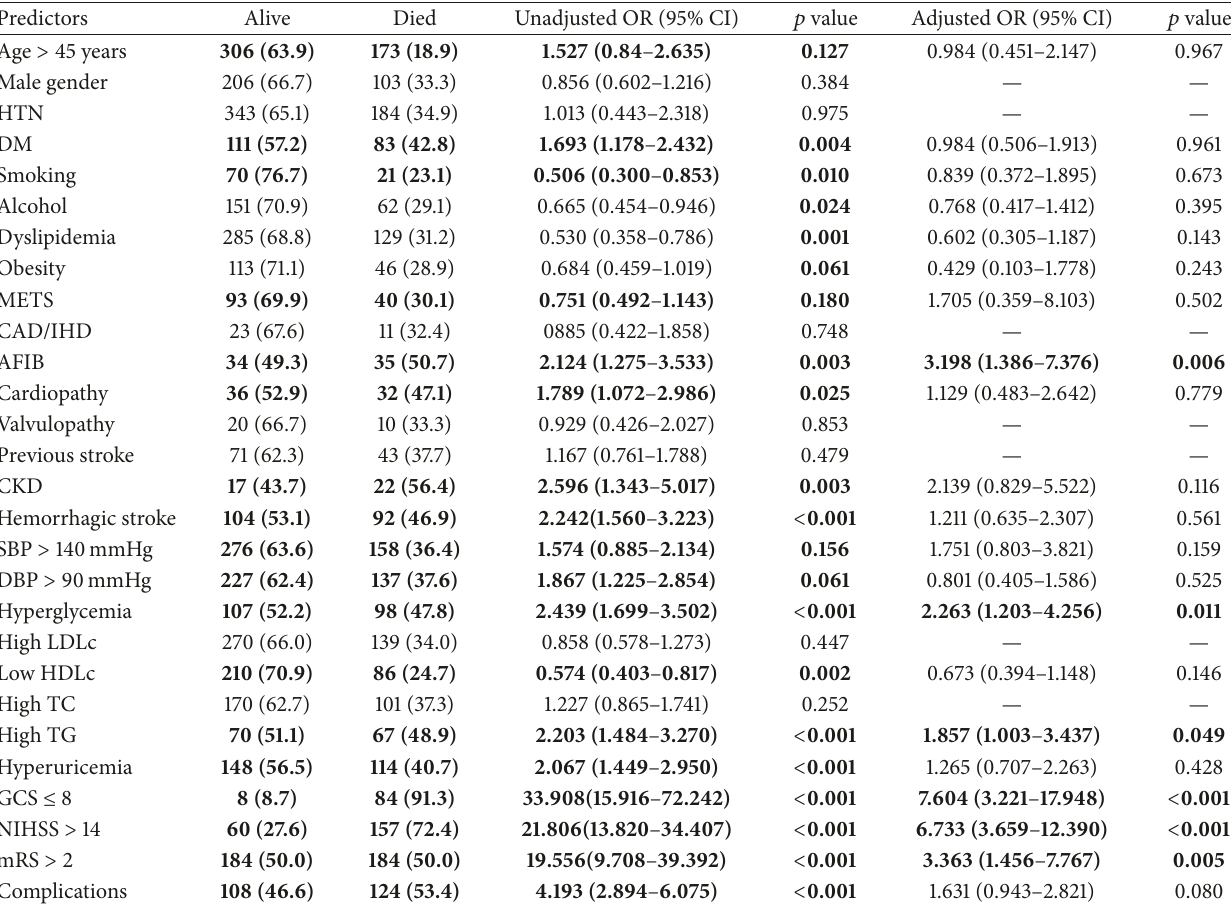
Table 3: Independent predictors of death within 3 months after